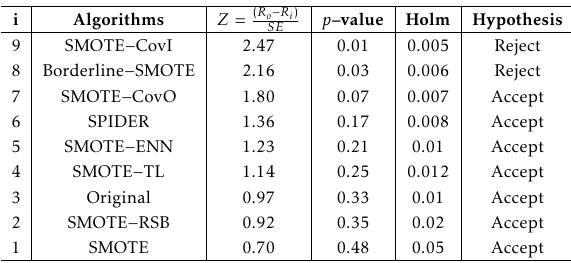
Table 4 summarizes the results of Holms test taking ADASYN as a control method, all hypotheses